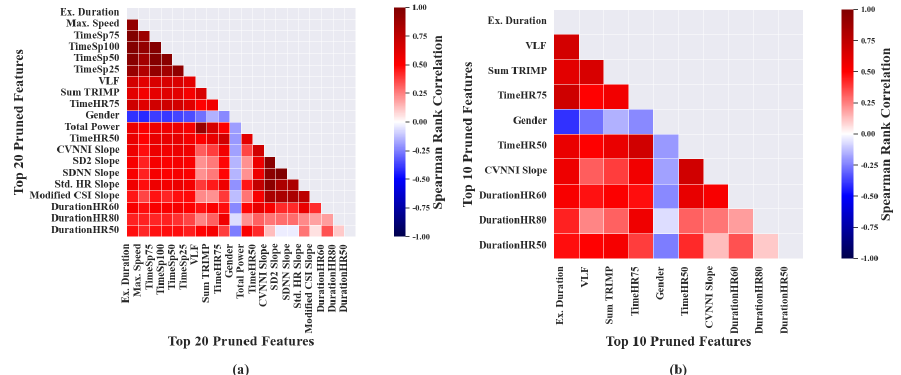
Figure 2. Heat maps depicting bivariate collinearity among predictor variables. Each of the subfigures shows the Spearman’s correlation coefficient between: ( a ) the top 16 ranked features associated with exercise data; ( b ) the top 10 pruned features associated with exercise data.